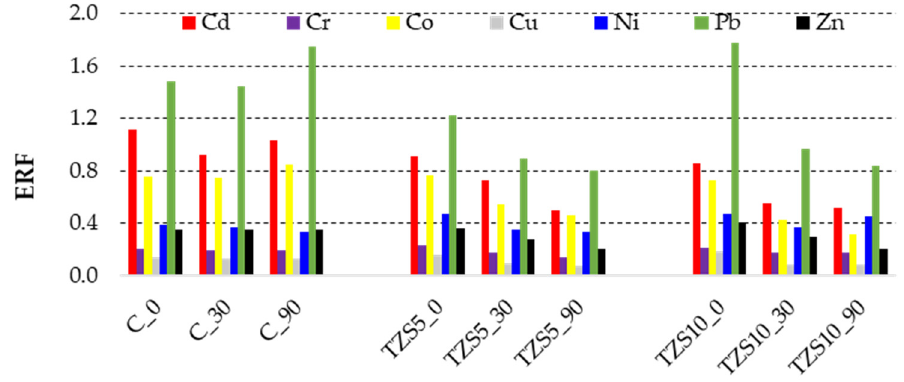
Figure 5. Environmental risk factor (ERF) of potentially toxic elements in the control soil (C) and soil amended with 5% (TZS5) and 10% (TZS10) zeolite at 0, 30, and 90 days after amendment.